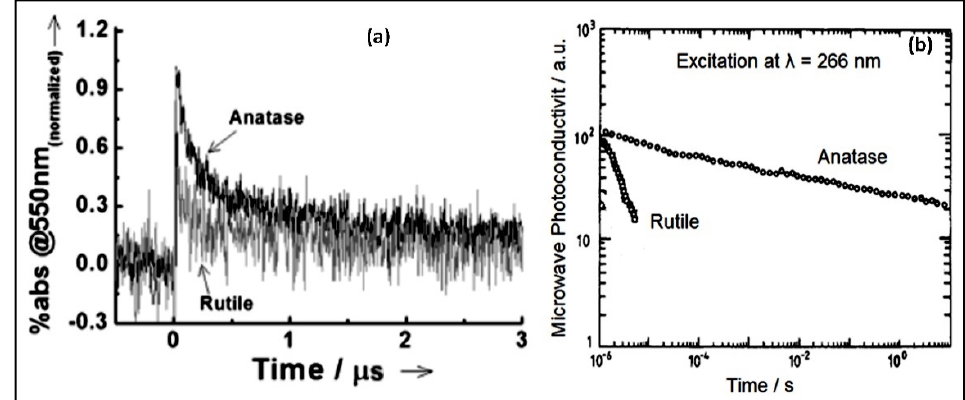
Figure 8. ( a ) Time-resolved diffuse reflectance spectroscopy measurements with normalized absorbance at 550 nm during the 355 nm laser excitation (1.5 mJ pulse −1 ) of aqueous suspensions of anatase and rutile TiO 2 in water. Adapted with permission from reference [189]. Copyright 2013 John Wiley and Sons. ( b ) Photoconductivity of TiO 2 powders after a laser flash excitation at 266 nm with energies of 0.5 and 1 mJ cm −2 for anatase and rutile, respectively. Adapted with permission from reference [190]. Copyright 1990 American Chemical Society.